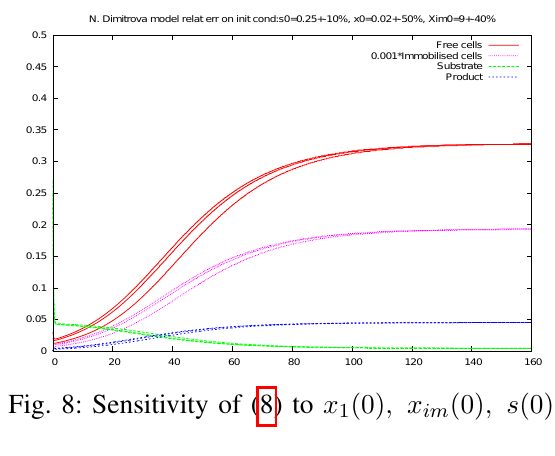
Fig. 8: Sensitivity of (8) to x 1 (0) , x im (0) , s (0)